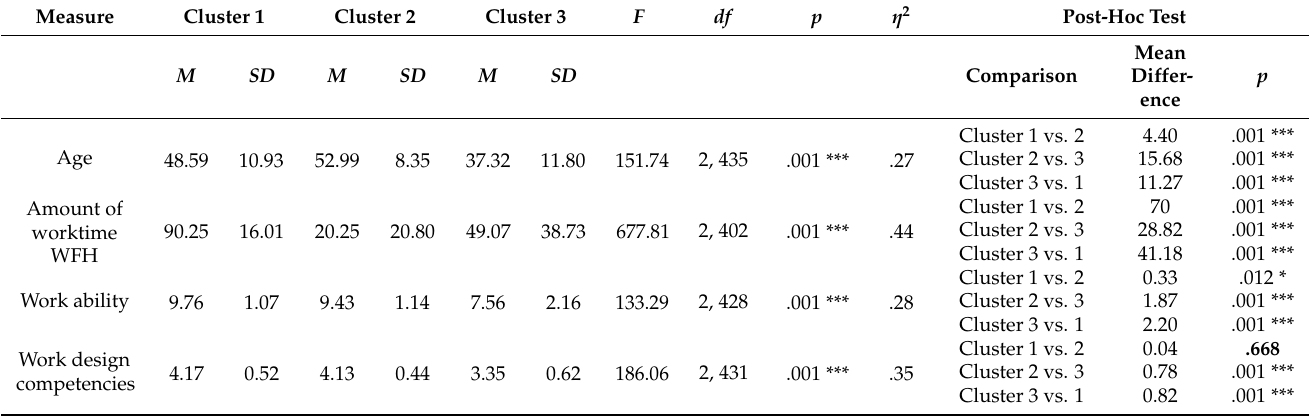
Table 2. Descriptive statistics of the test variables divided into clusters ( N = 735), analyses of variance, and post-hoc